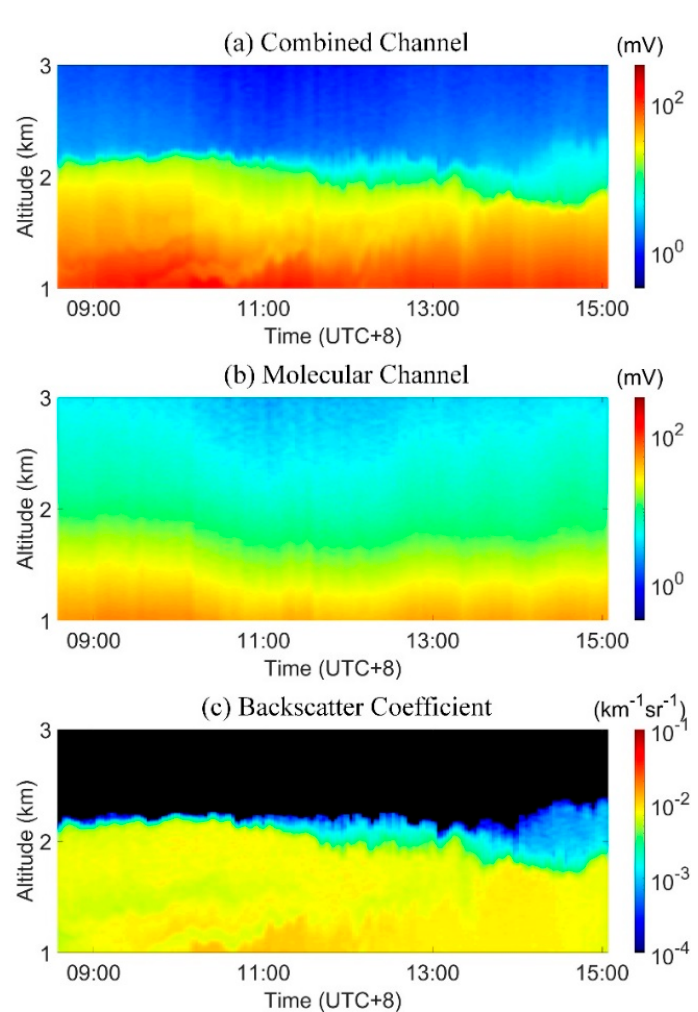
Figure 7. The image of the combined channel ( a ), the molecular channel ( b ), and the backscatter coefficient ( c ),